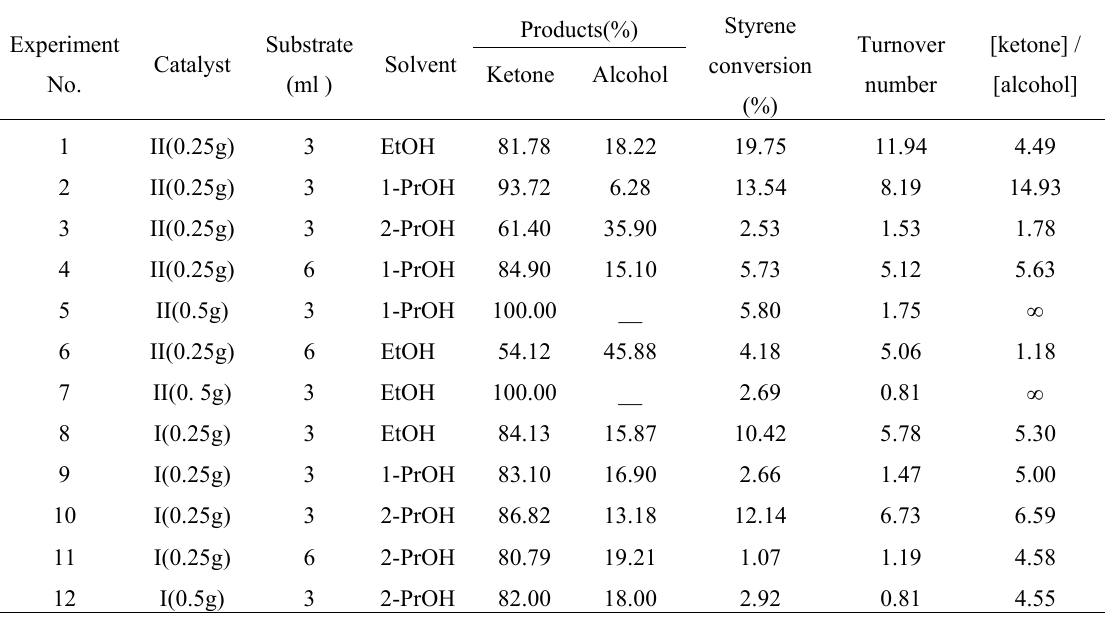
Table 2. The % of the products and styrene conversion to the products, turnover number of reactions and [acetophenone]/[1- phenylethanol] ratio after 8h under different experimental conditions.